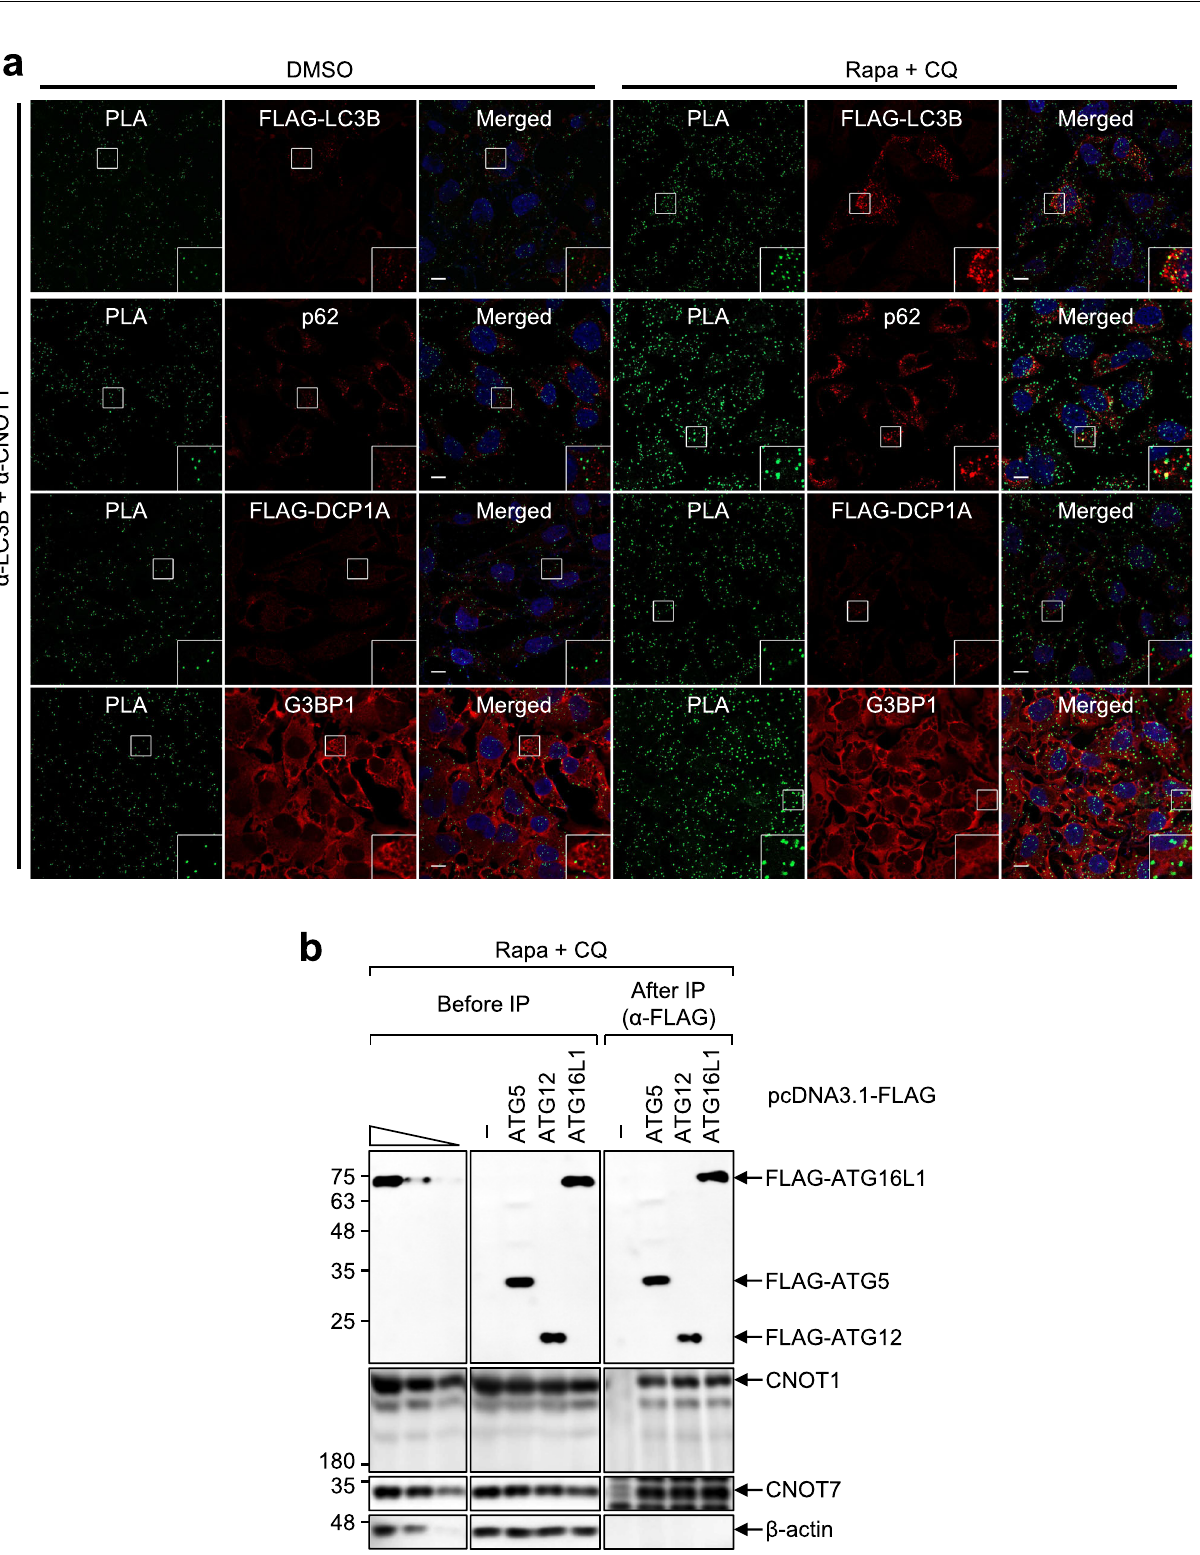
incubated with 0.5U/ μ l T4 PNK (New England Biolabs) and 0.125mM ATP for 15min at 37°C and washed twice with PNK + EGTA buffer. Finally, RNAs and proteins bound to the beads were eluted using a lithium dodecyl sulfate sample buffer (Invitrogen). To isolate RNA covalently cross-linked to proteins, the samples were subjected to SDS-PAGE in a Novex NuPAGE Bis-Tris gel (Invitrogen), and the separated proteins were transferred to a nitrocellulose membrane. The membranes